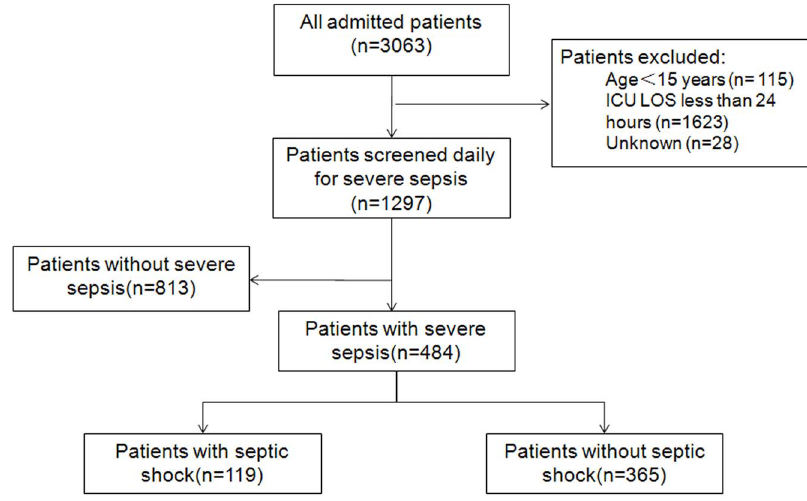
Figure 1. Flow diagram of enrolled patients and their outcome. ICU, intensive care unit; LOS, length of stay. doi:10.1371/journal.pone.0107181.g001 PLOS ONE |